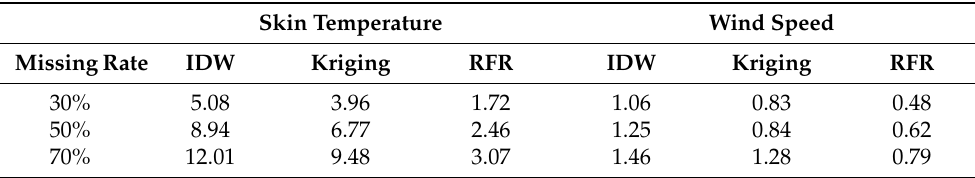
Table 1. Reconstruction performance (RMSE) of skin temperature and wind speed by IDW, Kriging and RFR methods under different missing rates. Skin Temperature Wind Speed Missing Rate IDW Kriging RFR IDW Kriging RFR 30% 5.08 3.96 1.72 1.06 0.83 0.48 50% 8.94 6.77 2.46 1.25 0.84 0.62 70% 12.01 9.48 3.07 1.46 1.28 0.79 Figure 8 indicates that the spatial distribution of skin temperature is characterized by the warmer regions at the outer ocean and colder at the inner land. The reconstructions at the ocean achieved by Kriging and IDW methods are cooler than the true values, while the results on land are warmer. The reason could be that these interpolation methods impute the missing values by approximating the average of the surrounding data. When the missing rate is large or the spatial pattern has a continuum missing, the surrounding data are inadequate to achieve good accuracy. On the other hand, the deep learning method learns the global spatial dependence, which employs more global valid data to impute the missing information instead of the limited surrounding data. Similar to the skin temperature, the deep learning method significantly outperforms the Kriging and IDW for surface wind speed, with improvements of 36% and 50%, respectively, on average for the three missing rates. (Table 1 and Figure 9). Especially at a high missing ratio (70%), the RFR reduces the error by 38% and 46% for Kriging and IDW, respectively.